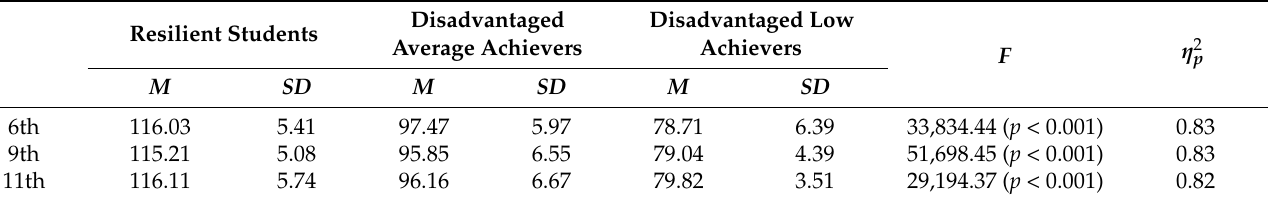
Table 3. The comparison of academic achievement among resilient students, disadvantaged average achievers and disadvantaged low